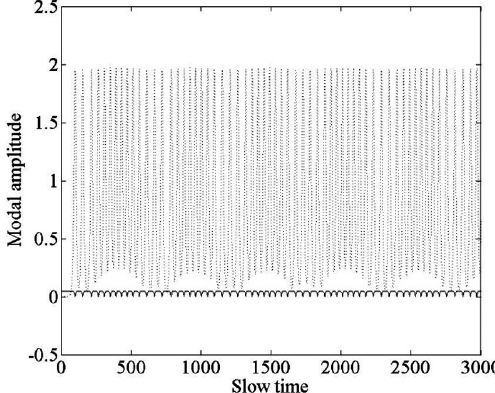
Fig. 7. Undamped modal amplitudes.